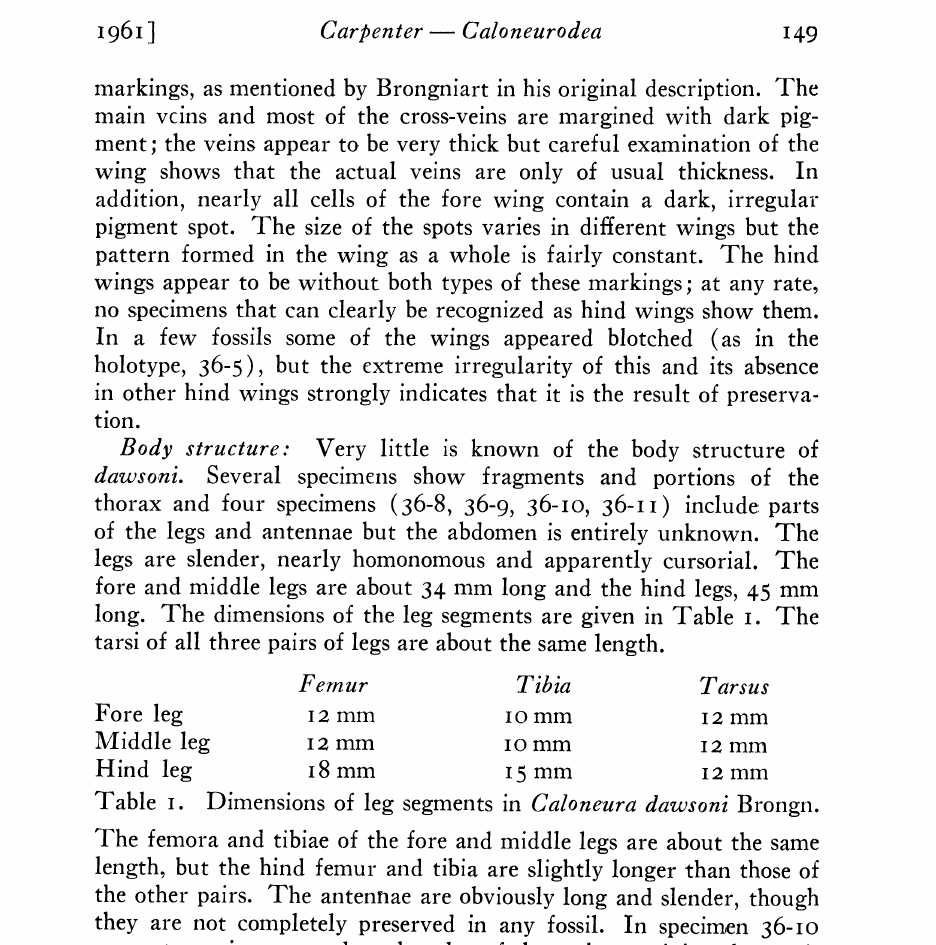
Table I. Dimensions of leg segments in Caloneura dawsoni